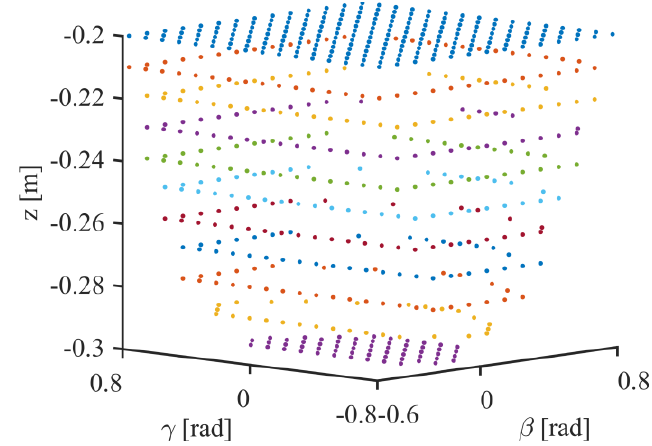
Figure 5. 692 target poses of the 2UPR-RPU parallel manipulator. Table 5. Specified geometric errors [13,26] for geometric error identification.